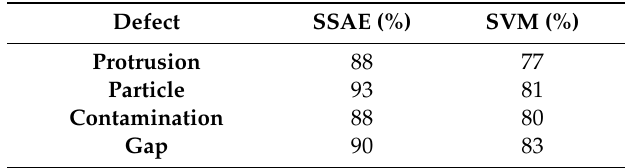
Table 1. Average recognition accuracy results comparison between stacked sparse auto-encoder (SSAE) model and Support Vector Machine (SVM) technique.